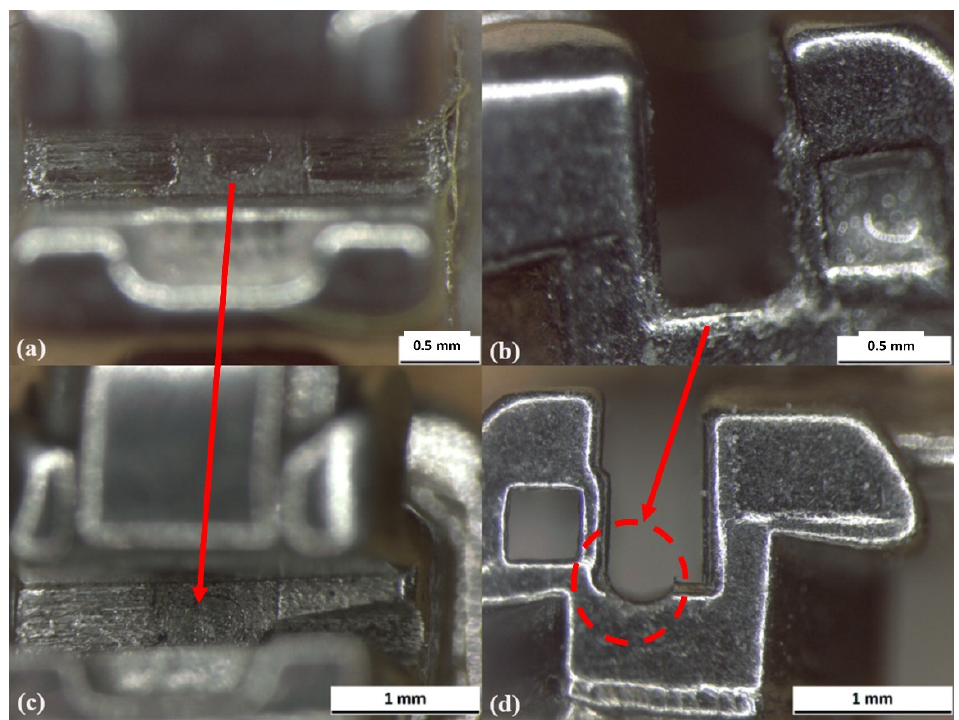
Figure 8. SB1 bracket (Manufacturer 1) in top and side view: ( a , b ) before the test; ( c , d ) after the test. The XRF results and the overall evaluation for self-ligating brackets are shown in Tables 8 and 9, respectively. Table 8. XRF Self-ligating bracket results. Percentage by weight.